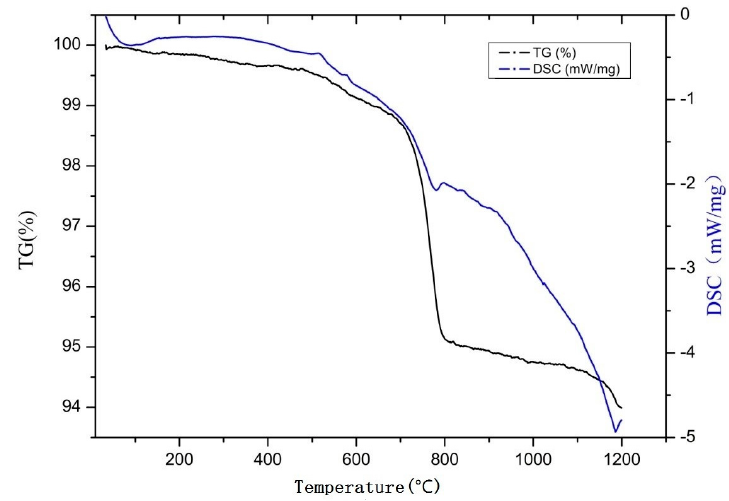
Figure 10. Thermo-gravimetric–differential scanning calorimetry (TG–DSC) curve of raw copper mine tailings (10 °C~1200 °C; atmospheric conditions).